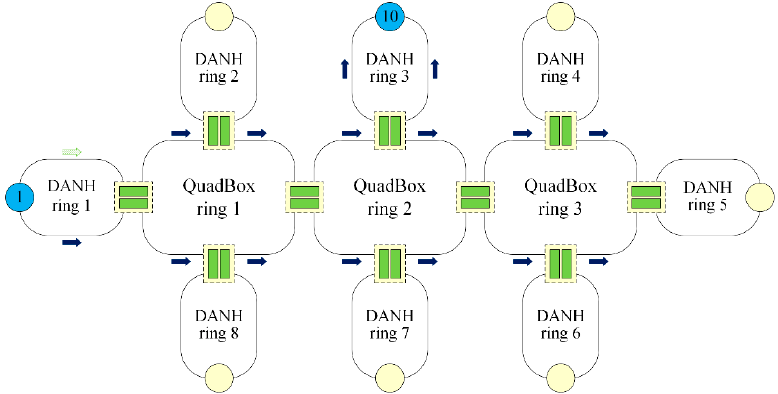
Figure 6. Forwarding the first sent frame in eEFA.